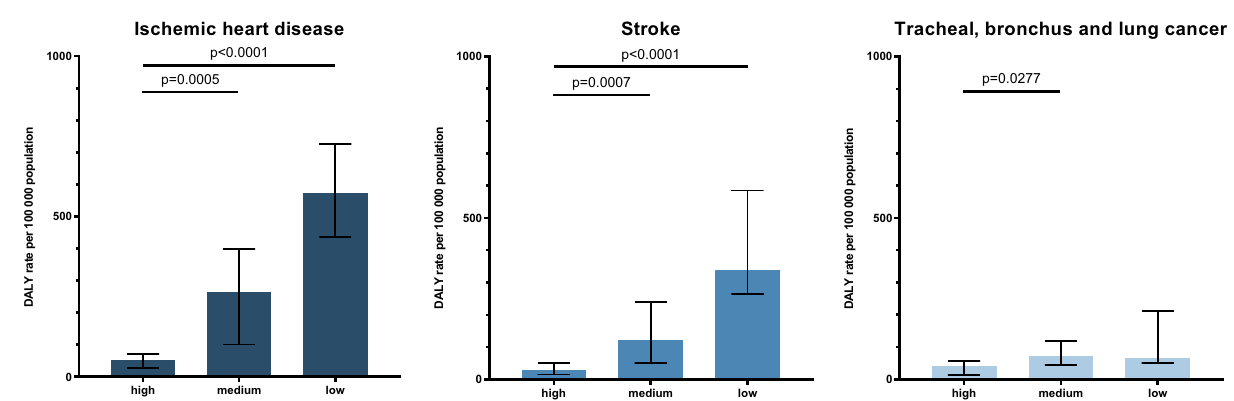
Figure 6. Comparison of countries by SDI and DALY rate attributable to air pollution for IHD, stroke and TBL cancer in 2019. Countries are categorised by SDI into three categories: high SDI, medium SDI and low SDI. Groups are represented as median with interquartile range. Statistical analysis by Kruskal–Wallis test by ranks with Dunn’s multiple comparisons test. Bonferroni correction for multiple tests was used to adjust significance